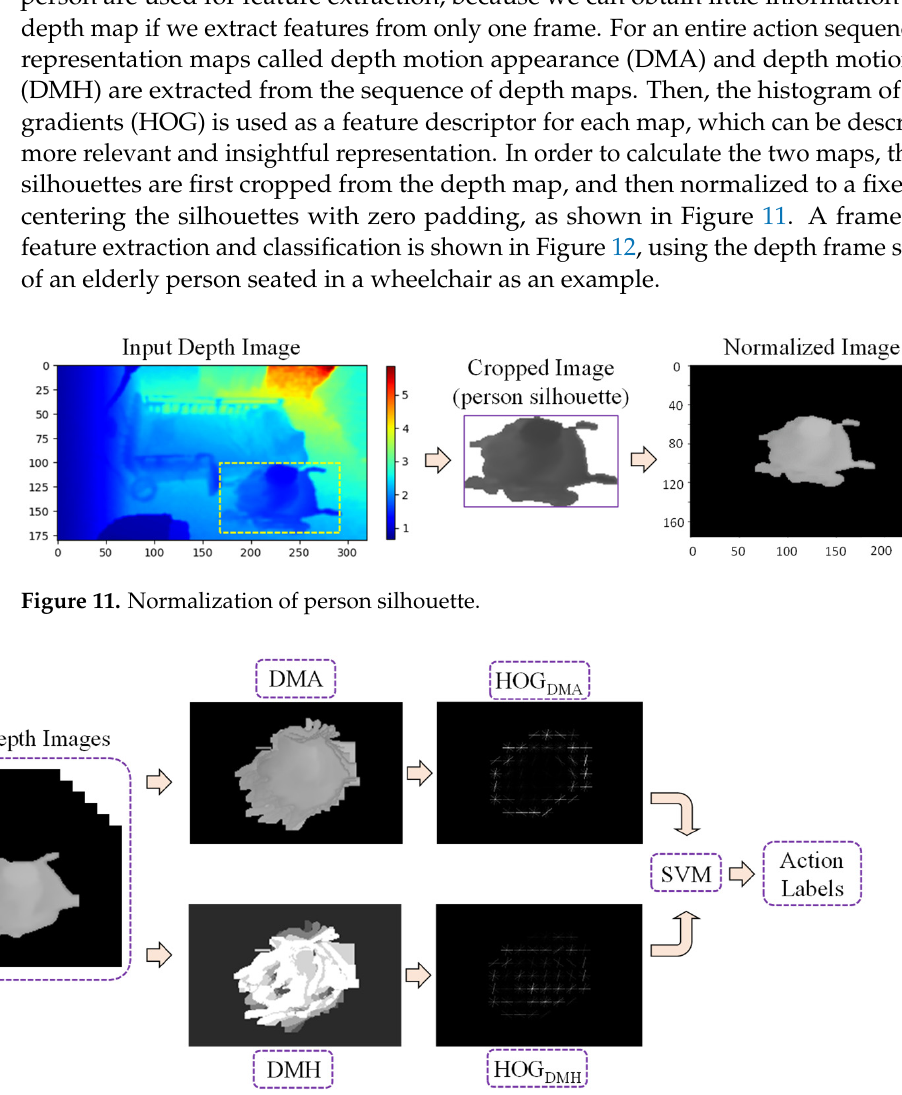
Figure 12. Feature extraction and classification framework.